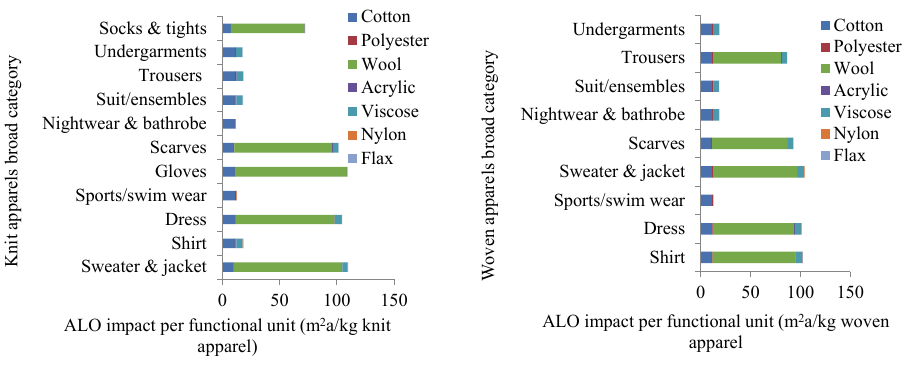
Fig. 9. ALO impact (per kilo-gram apparel) of knit and woven apparel broad